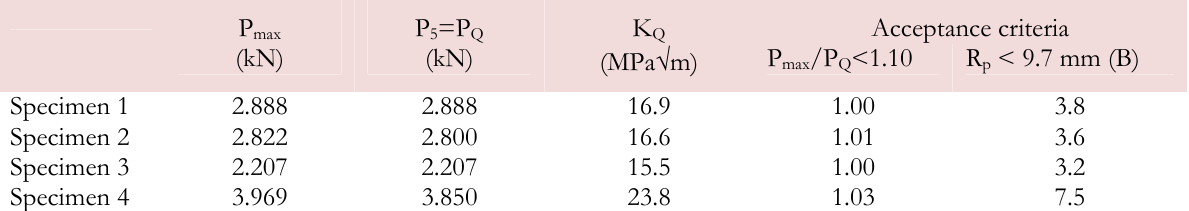
Table 2: Data obtained from the load- crack displacement